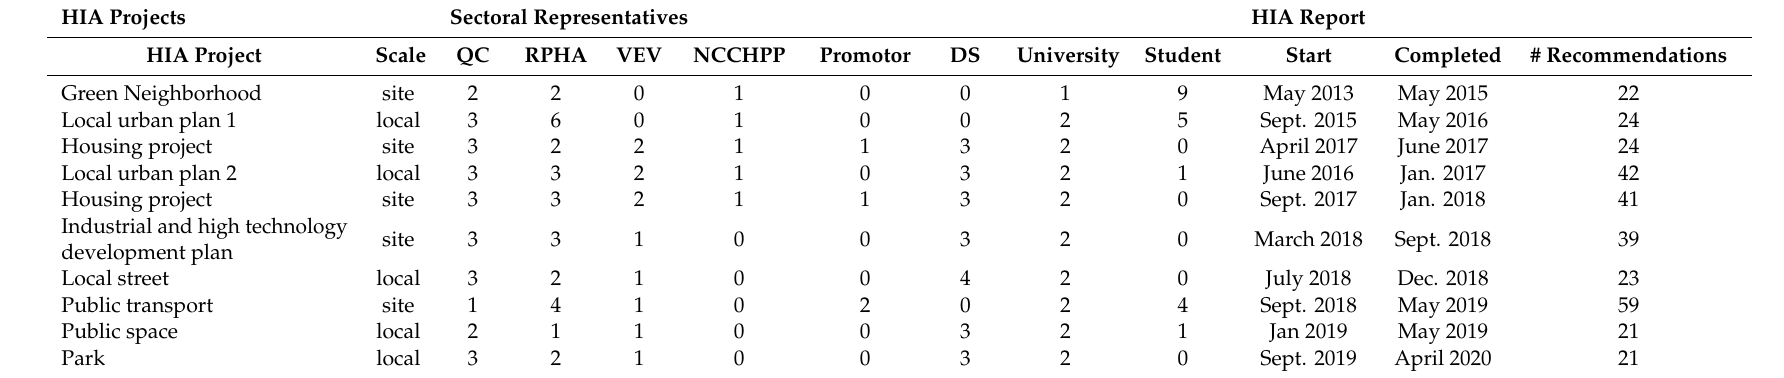
Table 1. Characteristics of the health impact assessments performed between 2013 and 2020 in the Quebec City